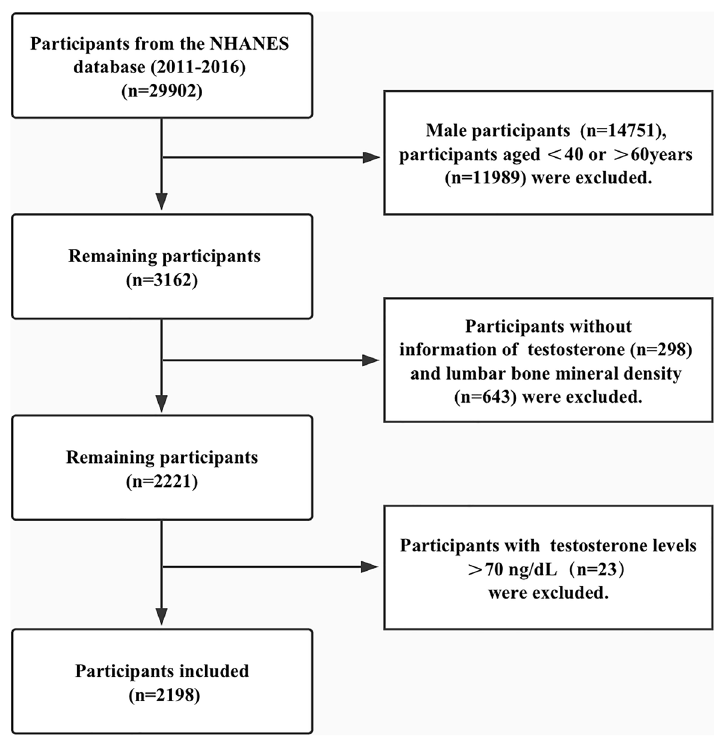
Figure 1. Flow chart of the screening process for the selection of eligible